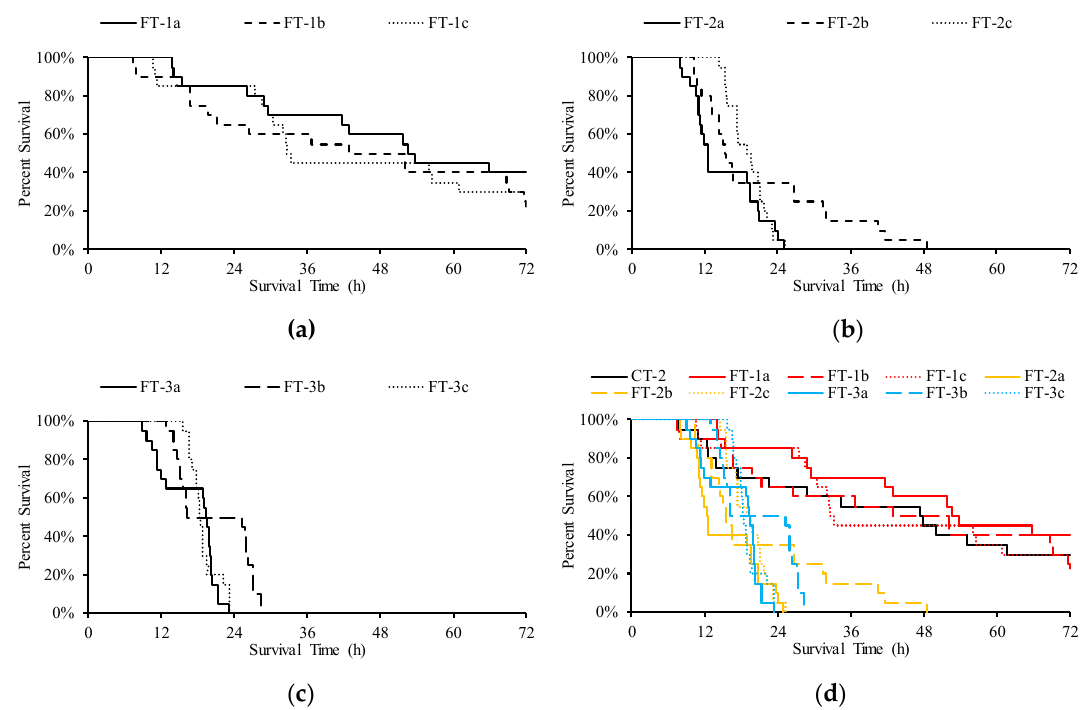
Figure 7. The result of survival analysis for each test, ( a – c ) are the percent survival in FT-1(a–c), FT-2(a–c), and FT-3(a–c), respectively, and ( d ) is the percent survival in all cases Table 5. Result of the log-rank Mantel–Cox tests between cases.